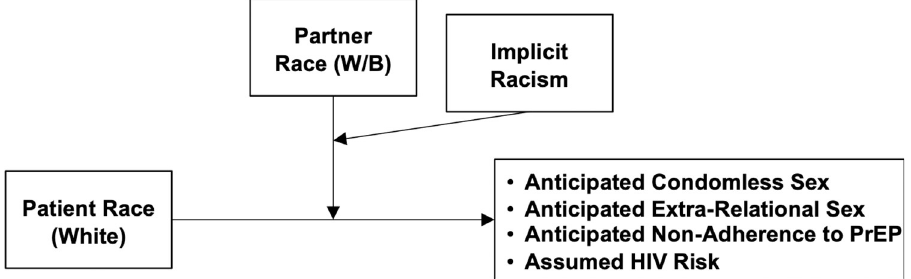
Fig 3. Conceptual diagrams of the moderation models. This series of moderation analyses was performed for each couple group (MSM, MSW, WSM). All analyses controlled for the gender identity of the patient and their partner, as well as participants’ year of training, sexual orientation, gender identity, and